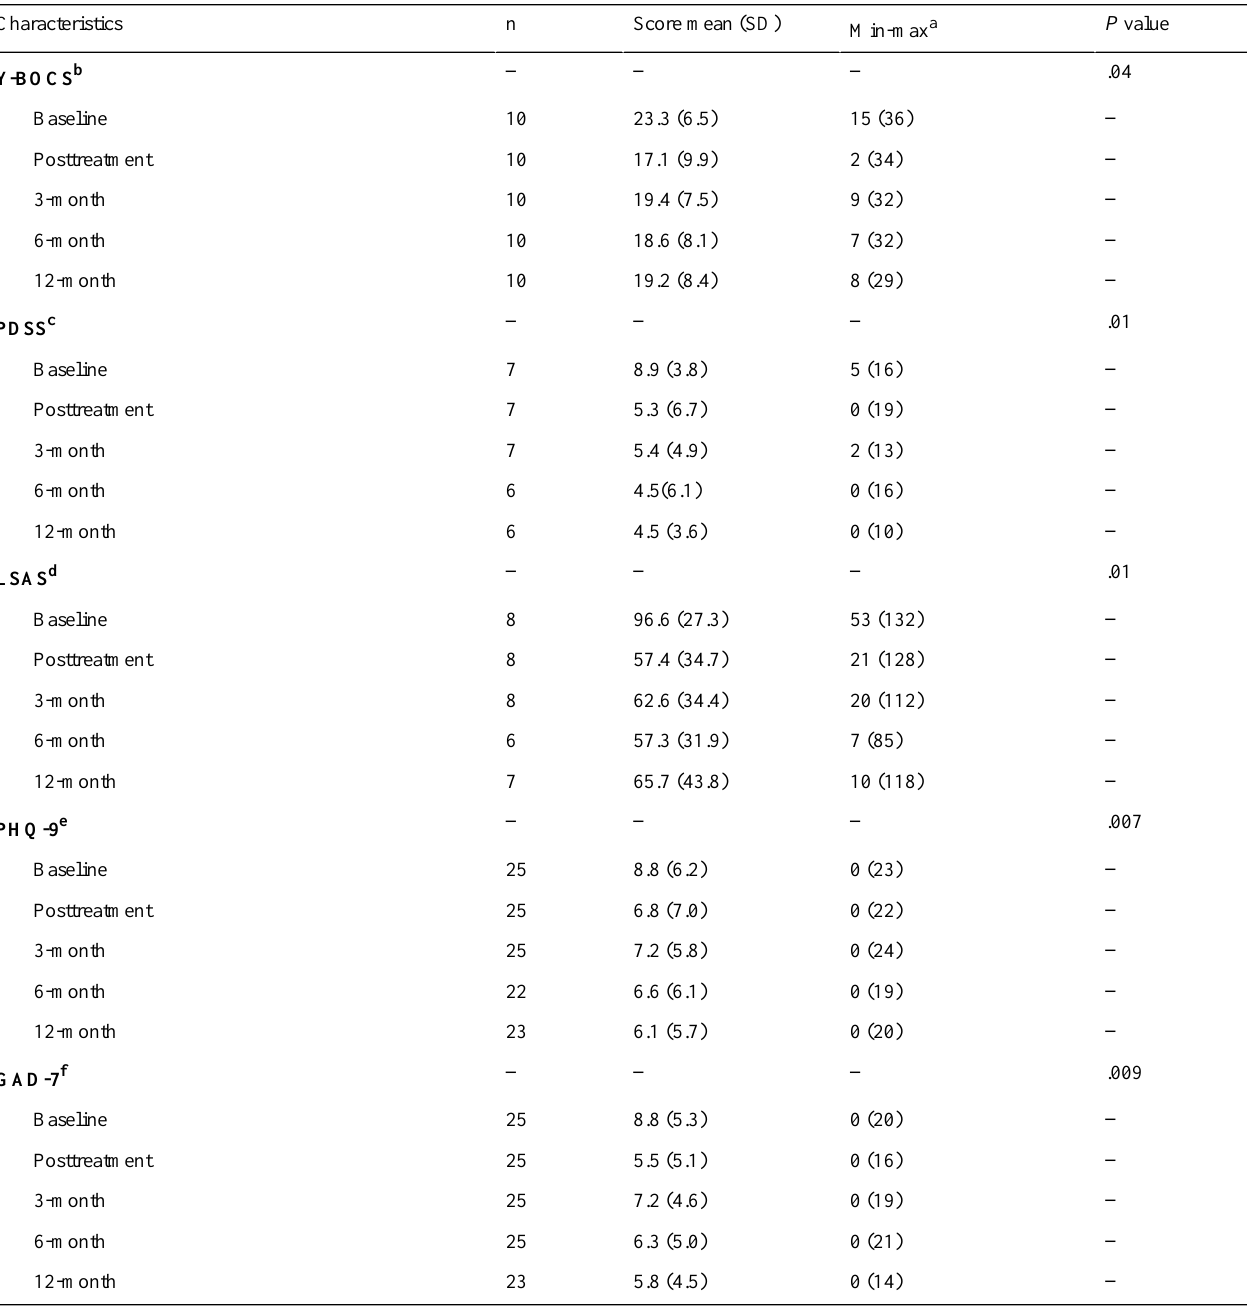
Table 2. Mixed-model analysis of variance results on changes in participant